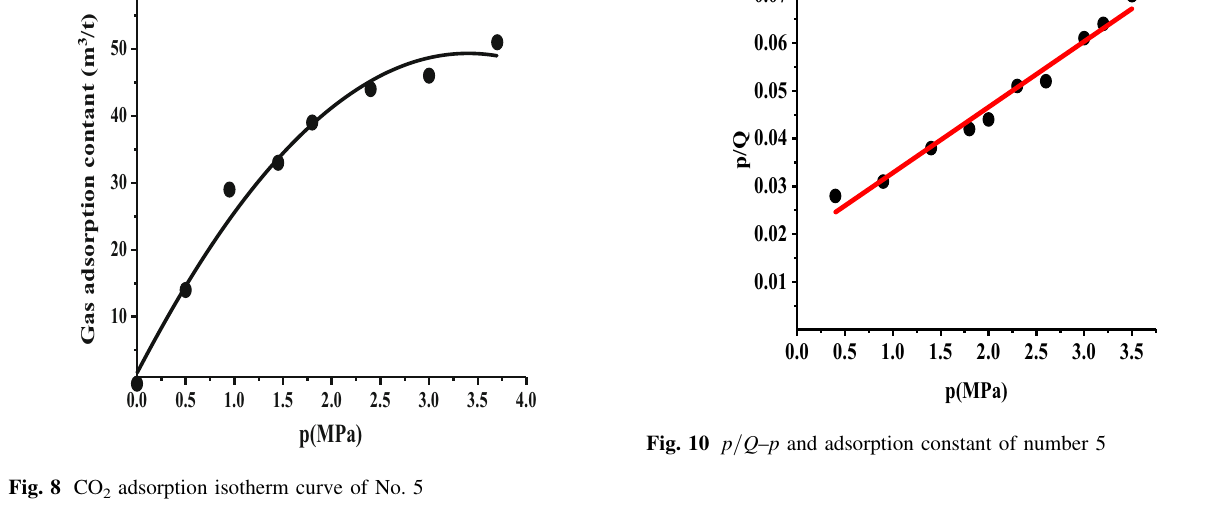
Fig. 8 CO 2 adsorption isotherm curve of No. 5